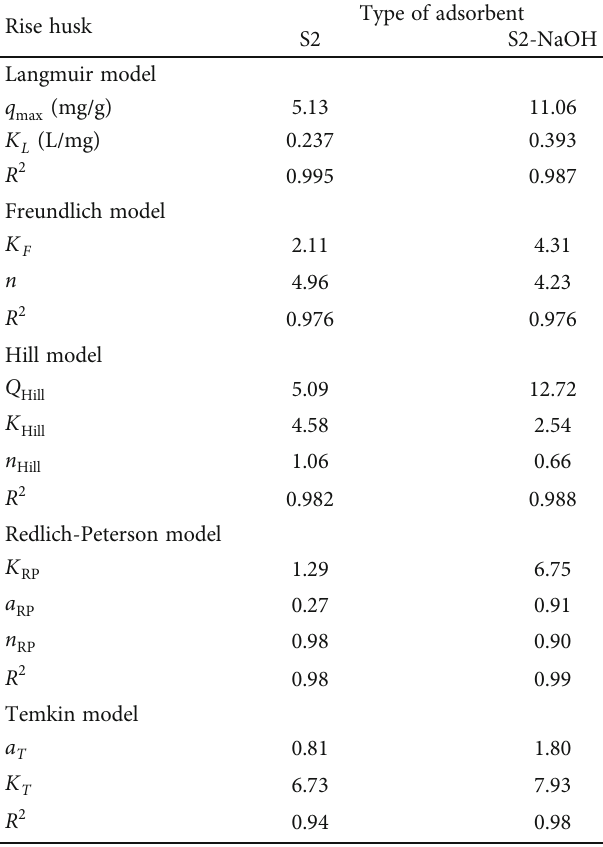
Table 5: Parameters of Langmuir and Freundlich adsorption